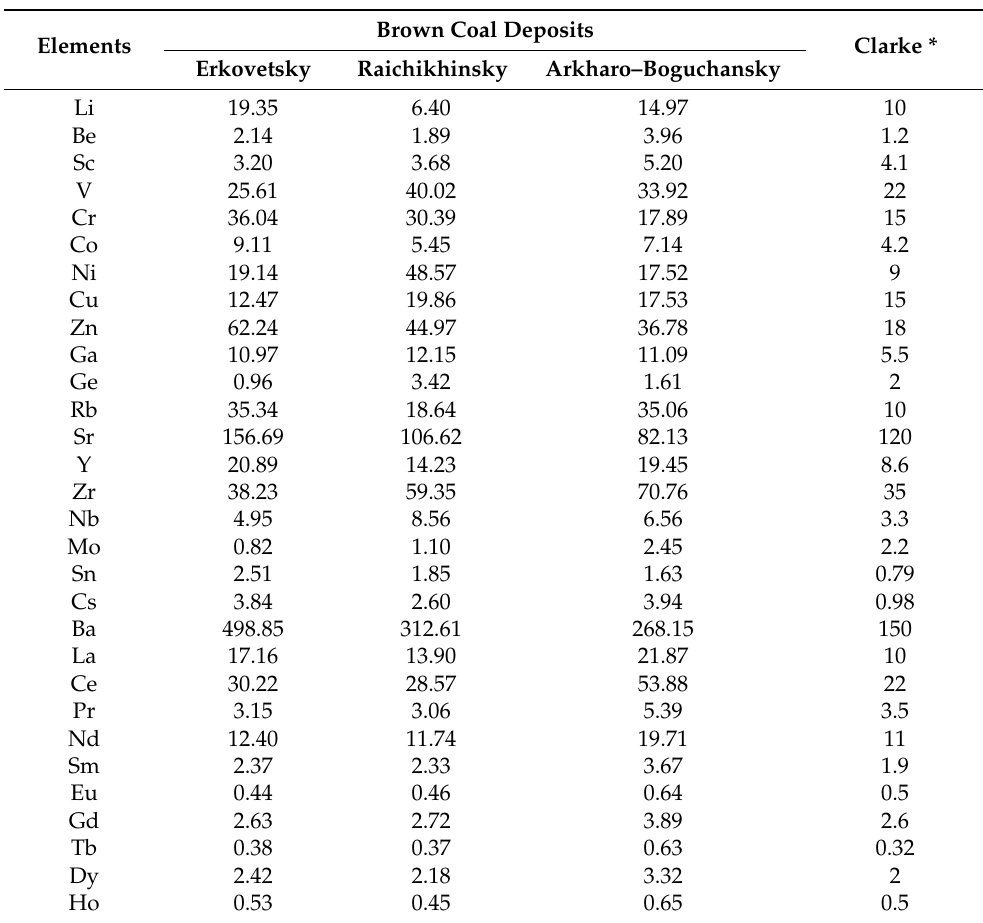
Table 3. Distribution of trace elements in Paleogene coals of the Erkovetsky, Raichikhinsky, and Arkharo–Boguchansky deposits (ppm). Brown Coal Elements